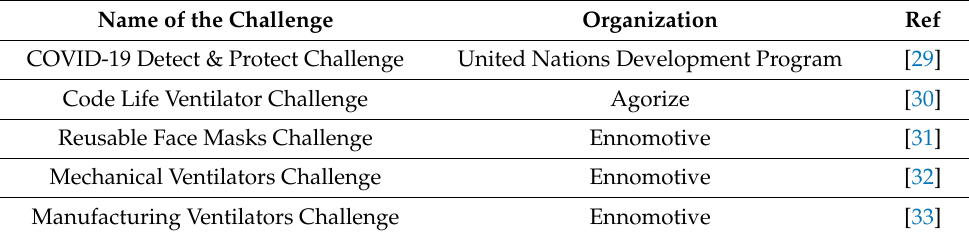
Table 2. List of international manufacturing challenges in the COVID-19